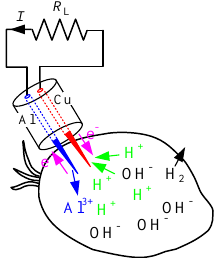
Figure 2. Fruit battery sensor concept.